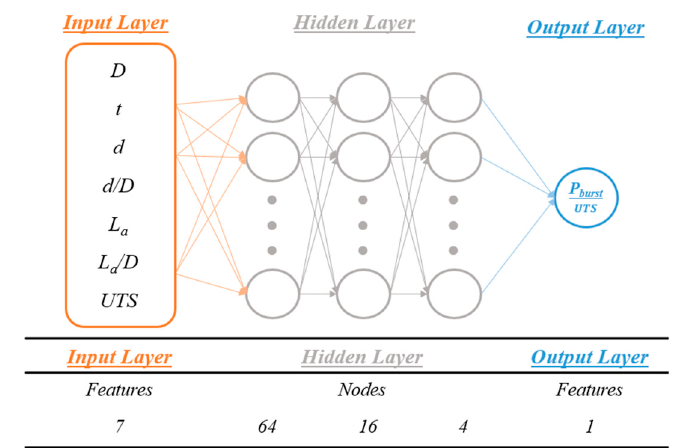
Figure 10. Defined DNN diagram